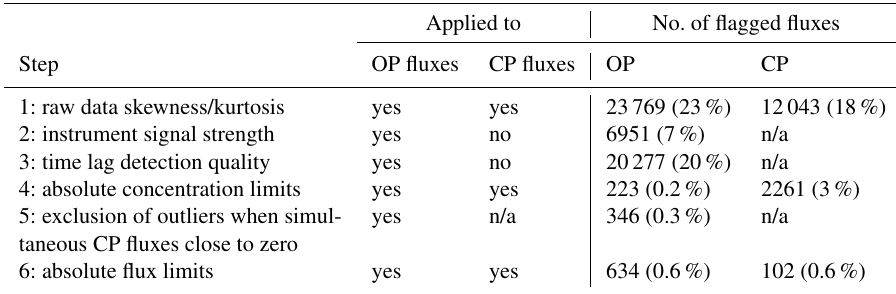
Table 3. Additional quality flagging steps after flux processing. Flagged fluxes were assigned to quality class 2 if not in this class already according to the Mauder and Foken (2004) quality assessment. As CP time lag detection quality had been addressed earlier during flux processing in EddyPro, it was not screened at this